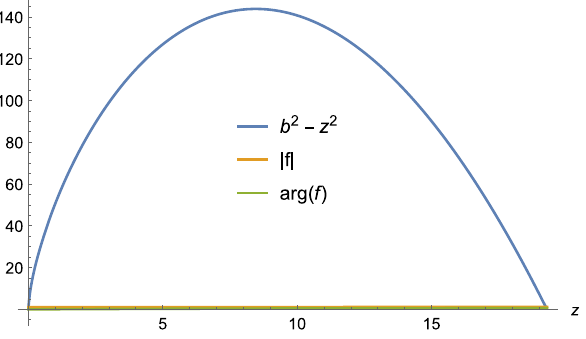
Fig. 10 The profile of δ branch for hyperbolic class in four